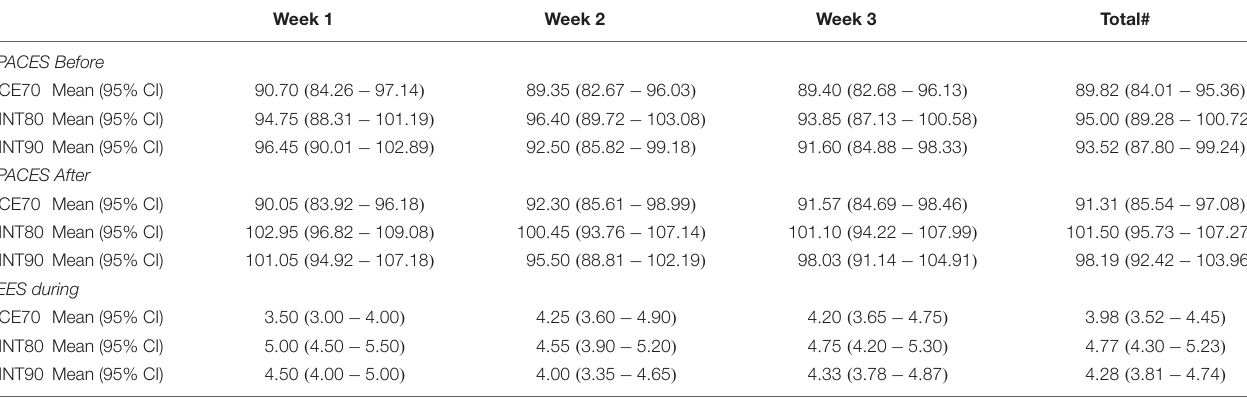
TABLE 3 | Physical Activity Enjoyment Scale before- and after- and Exercise Enjoyment Scale during exercise sessions.